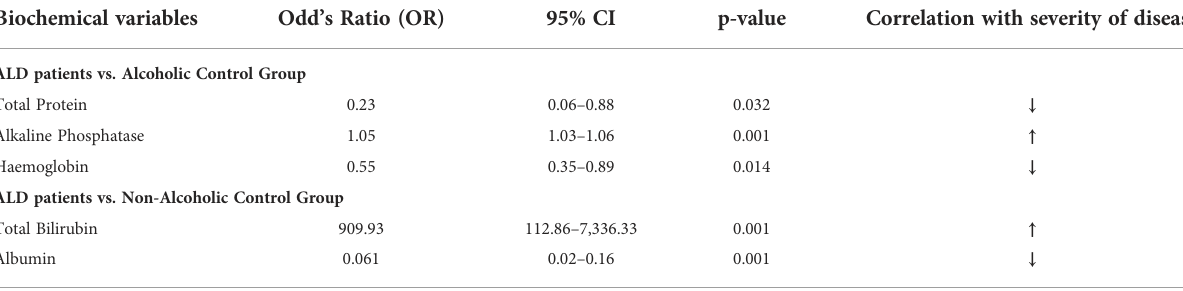
TABLE 3 Multivariate analysis in ALD patients and control groups for the severity of liver disease. Biochemical